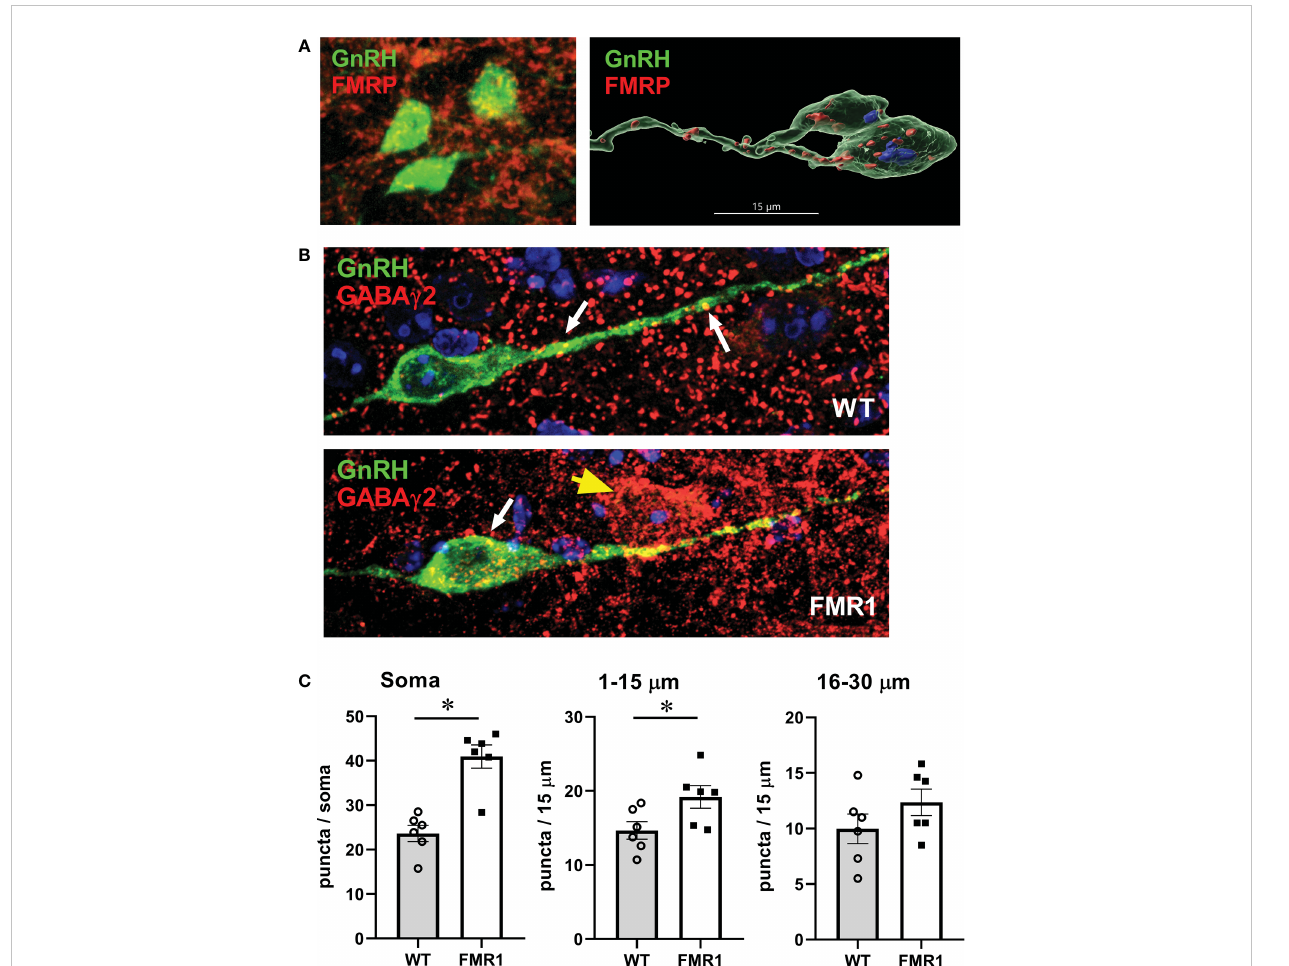
FIGURE 9 GnRH neurons of Fmr1 KO females have more GABA A receptors. (A) GnRH neurons (green) express Fmrp (red, top panels). (B) Representative GnRH neurons (green) from WT control (top panel) and Fmr1 KO mice (bottom panel) co-stained with GABA g 2 antibody (red). (C) Quanti fi cation of (B) Each point represents one animals and an average of 15-20 neuron per animal, and bars represent group means. Panels represent counts in the whole soma, along the fi rst 15 m m segment of the process (1-15 m m) and second 15 m m segment (16-30 m m) from the soma, as indicated above. Statistical signi fi cance (p < 0.05), determined with t – test followed by Tukey ’ s post hoc test, is indicated with a